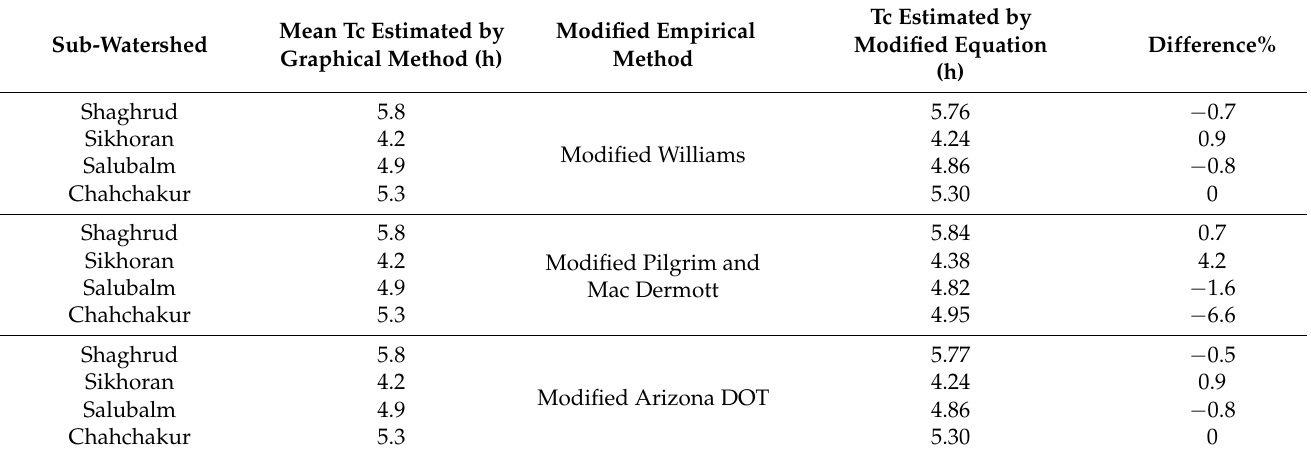
Table 9. Tc achieved by the modified top three empirical methods and their relative difference with mean Tc calculated by graphical method.